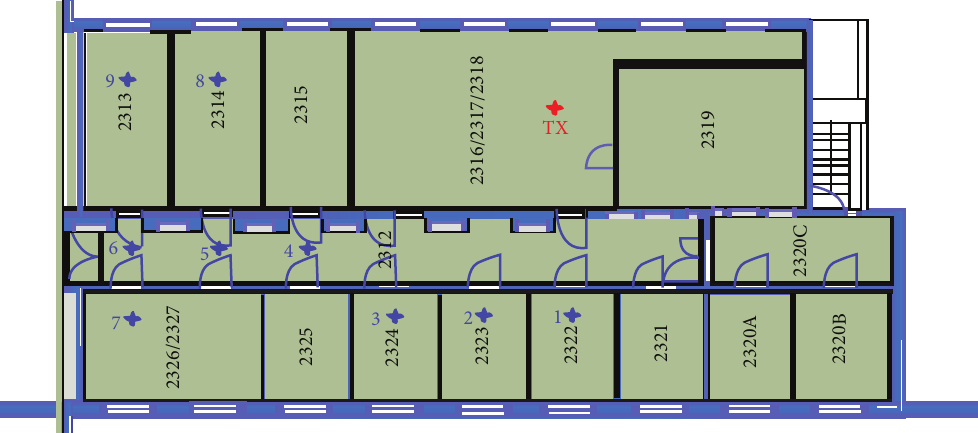
Figure 6: Building floor map of the downlink scenario.